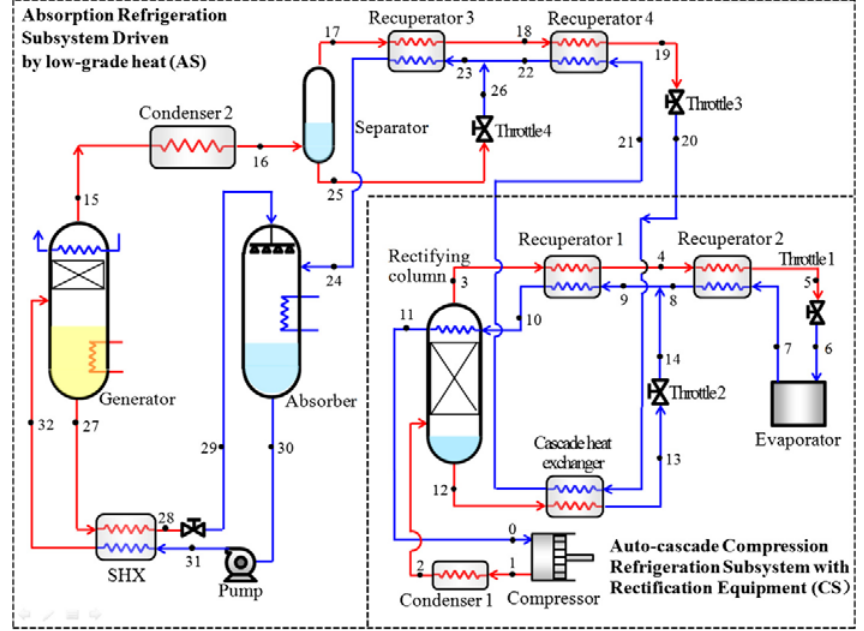
Figure 9. The schematic diagram of LACRS [94]. Reproduced with permission from [Elsevier], Elsevier, 2020.